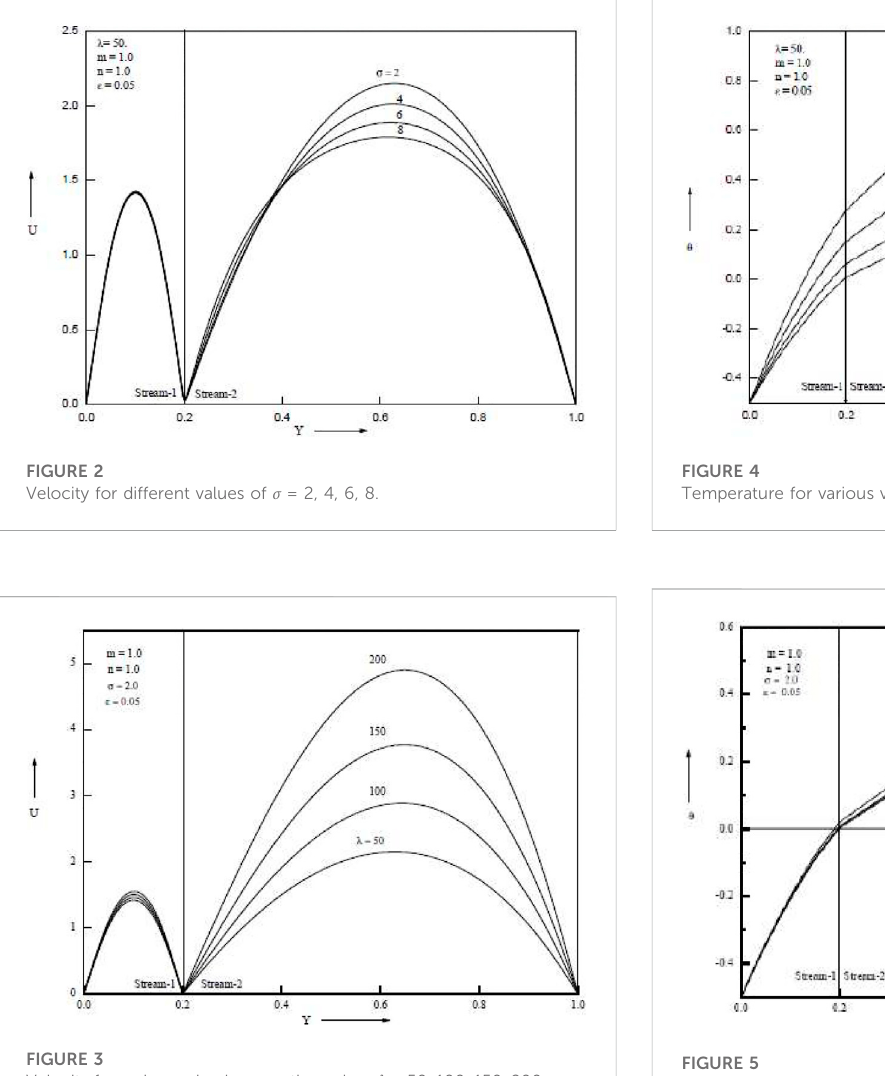
FIGURE 5 Temperature for various mixed convection values λ = 50, 100, 150,